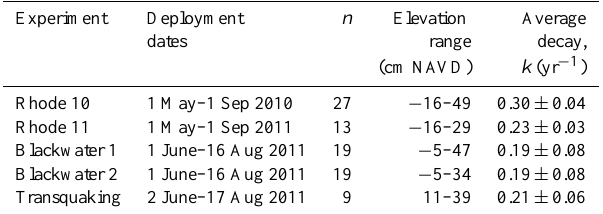
Table 1. Summary of decomposition experiments in 3 tributary rivers of the Chesapeake Bay. n refers to the number of undamaged bags retrieved at the end of the experiment, and therefore included in the decay analysis. Average decay represents a simple arithmetic mean of all measured decay coefficients, k , in each experiment and includes the standard